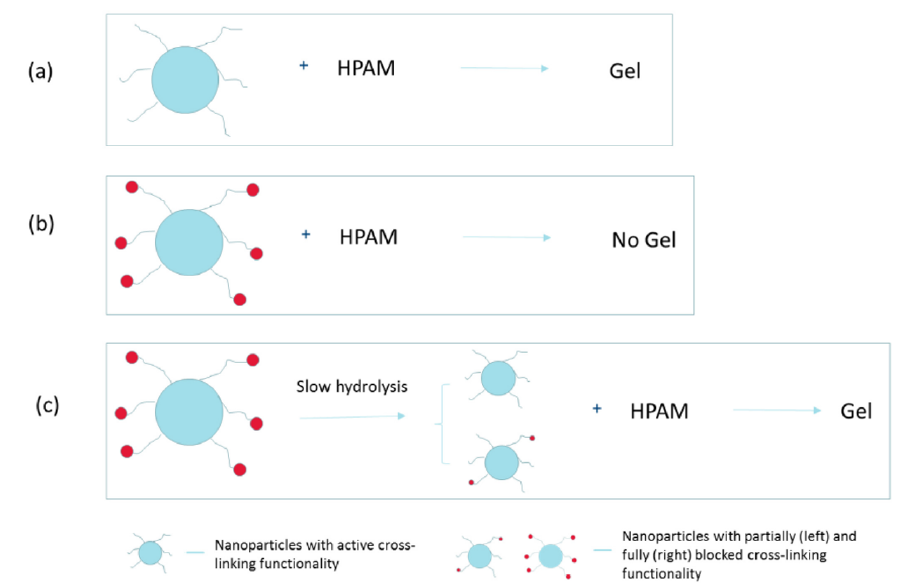
Figure 1. Principle of delayed gelation [38]. Nanomaterials with ( a ) active cross-linking functionality, ( b ) blocked cross-linking functionality, and ( c ) partially blocked cross-linking functionality by undergoing slow